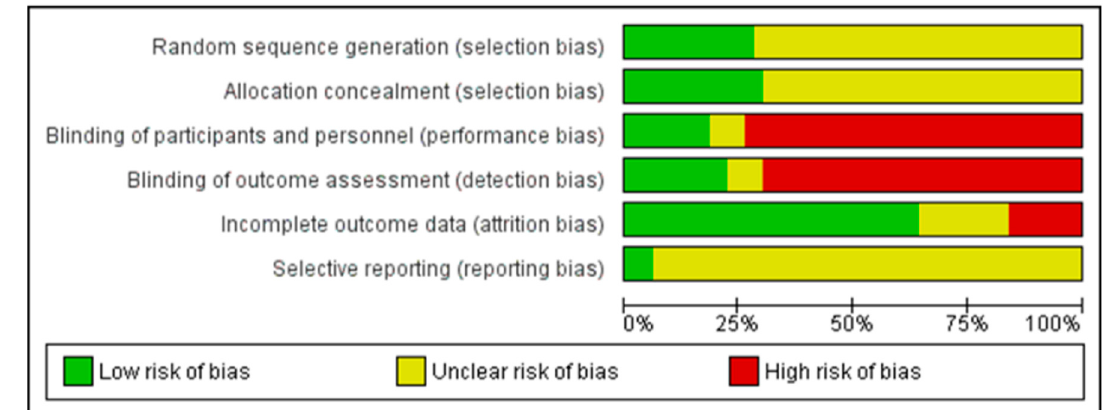
Figure 2. Bias assessment in the included studies. Risks are resented as percentages across different categories of bias. Unclear risk of bias (yellow) refers to studies with lack in systematic reporting of methods and results or when sources of funding were inadequately described. Green refers to low risk of bias; red refers to high risk of bias. Risk of bias: review authors’ judgements about each risk of bias item presented as percentages across all included studies. The main reason for unclear is lack of reporting, selective bias was only possible to assess in one trial with the protocol available in clinicaltrials.gov (Bethesda, MD, USA) and in other types of bias the source of funding for the project was unclear. Table 1. Characteristics of the 50 trials included in the meta-analyses.